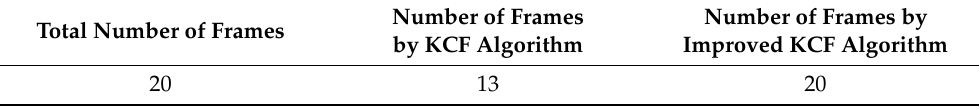
Table 5. Number of frames tracked by different object tracking methods. Total Number of Frames